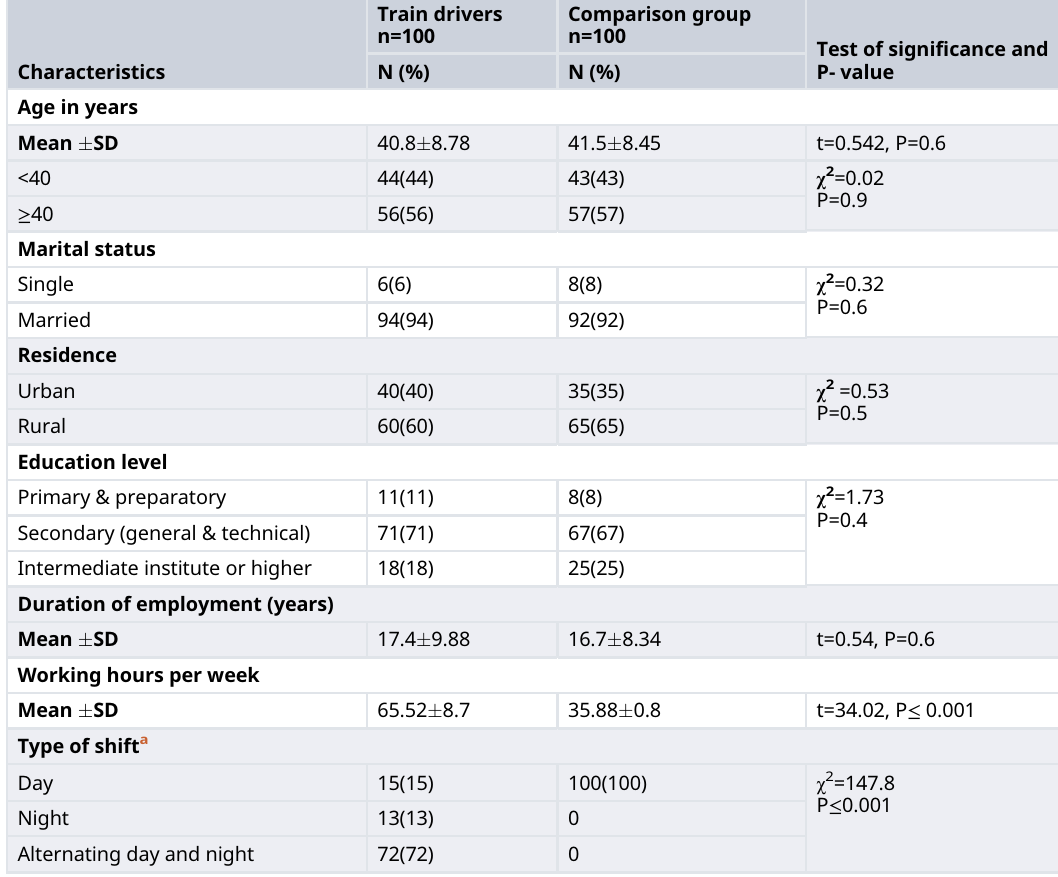
Characteristics